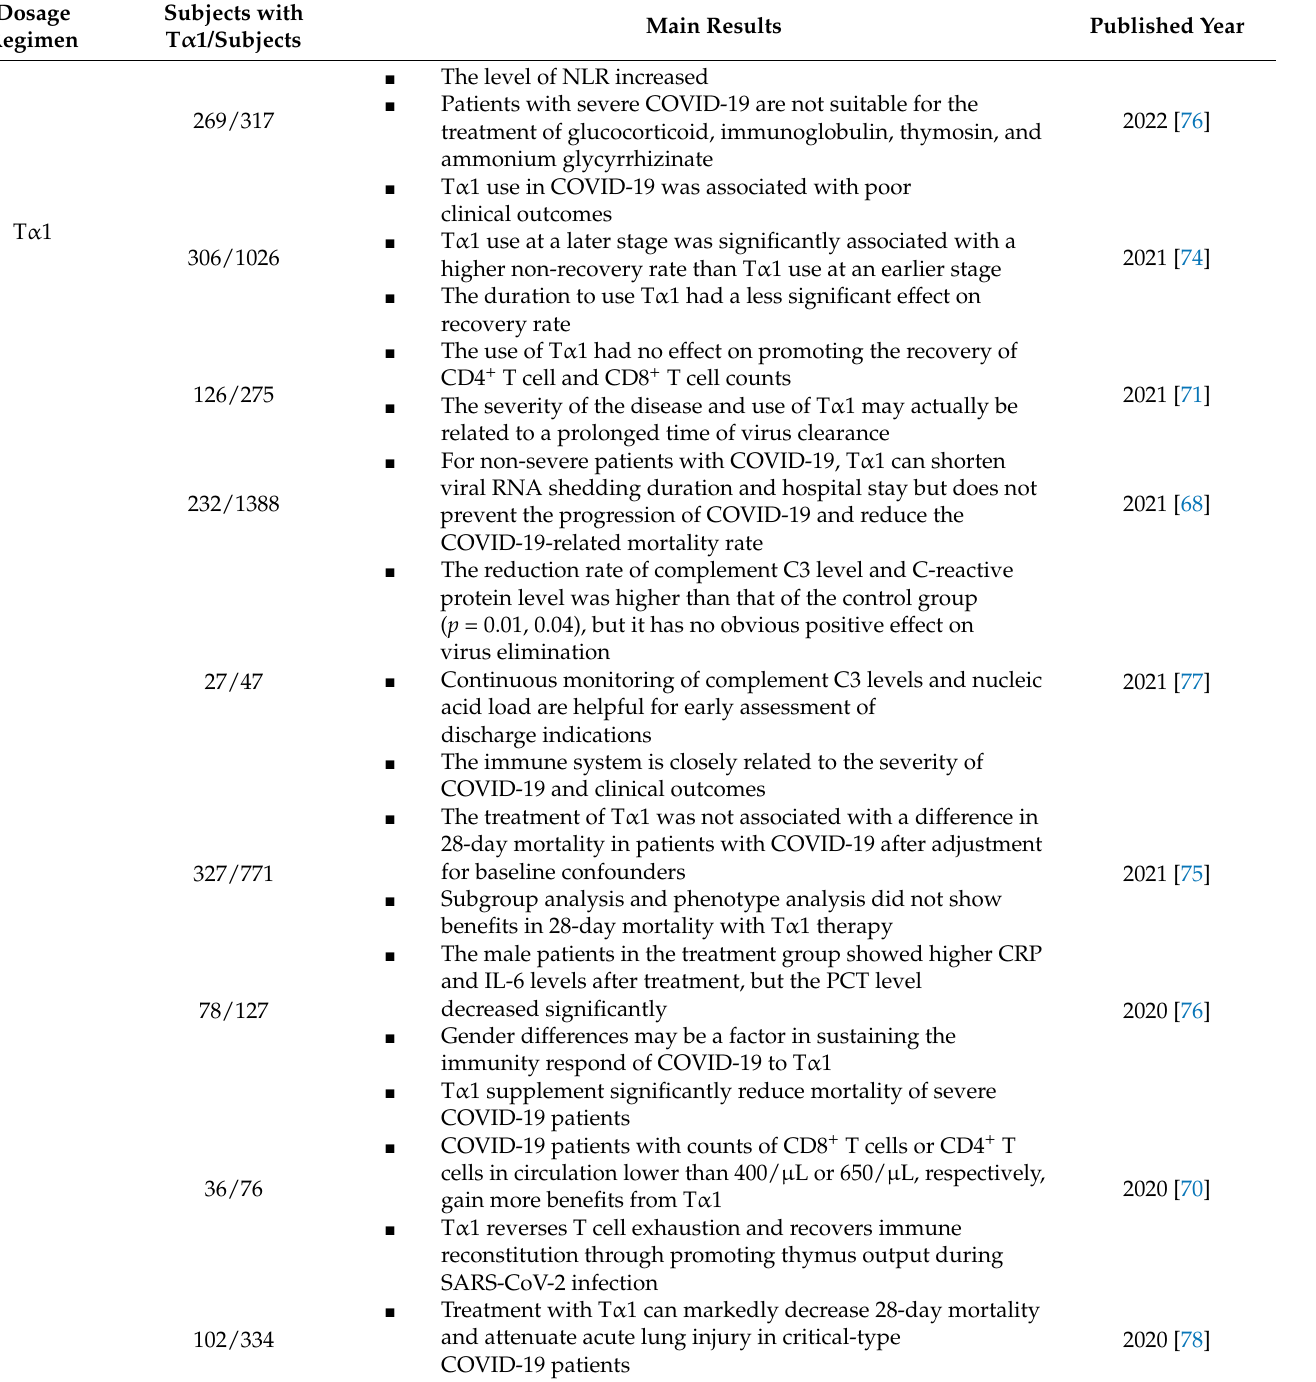
Table 1. Clinical research of T α 1 on